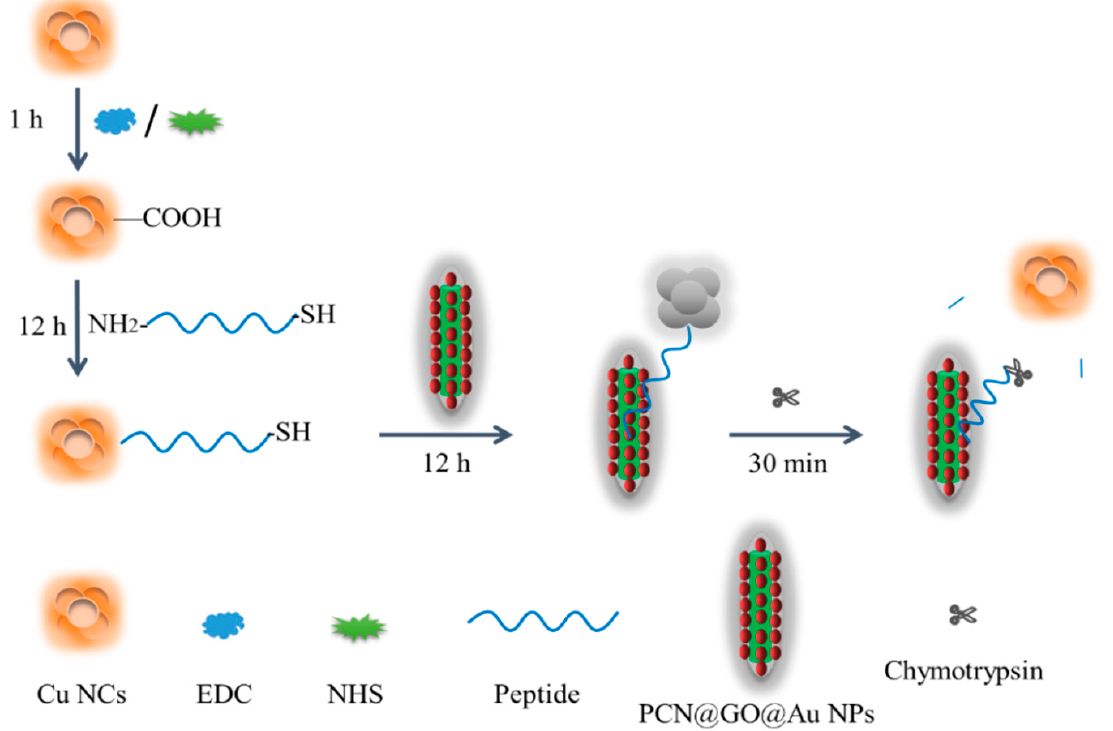
Figure 1. Scheme of chymotrypsin detection using copper nanoclusters and composite nanomaterials.